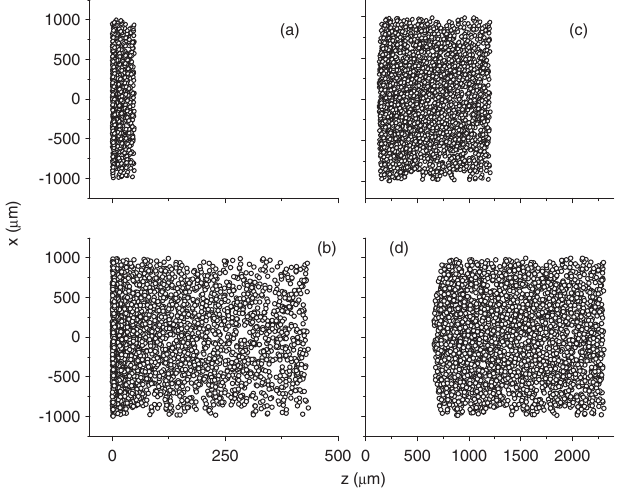
FIG. 11. A ð z; x Þ projection of a sample of the 20 000 macro- particles of an 1 nC electron bunch coming out from the photo- cathode: (a) t ¼ 5 psec , (b) t ¼ 10 psec , (c) t ¼ 15 psec , and (d) t ¼ 20 psec .